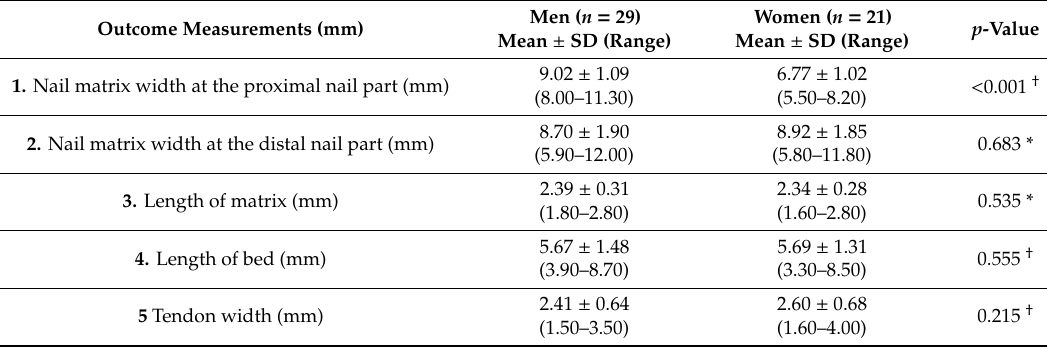
Table 2. Sex di ff erences for dimensions of the matrix, bed and EDL tendon of the second toes ( n = 50). Outcome Measurements (mm)